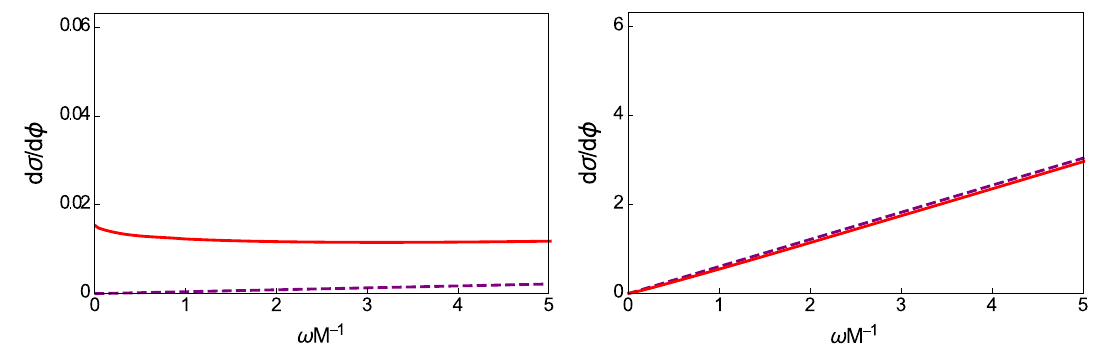
Fig. 1 d σ as a function of ω M − 1 for two different values φ = π/ 5 ( left panel ) and φ = π/ 100 ( right panel ). The graphs are plotted for d φ C = 0 . 01 M − 1 , D = 0 . 01 M − 1 and M f = 0. The solid ( dashed ) line represents the result for the fermionic (bosonic) case